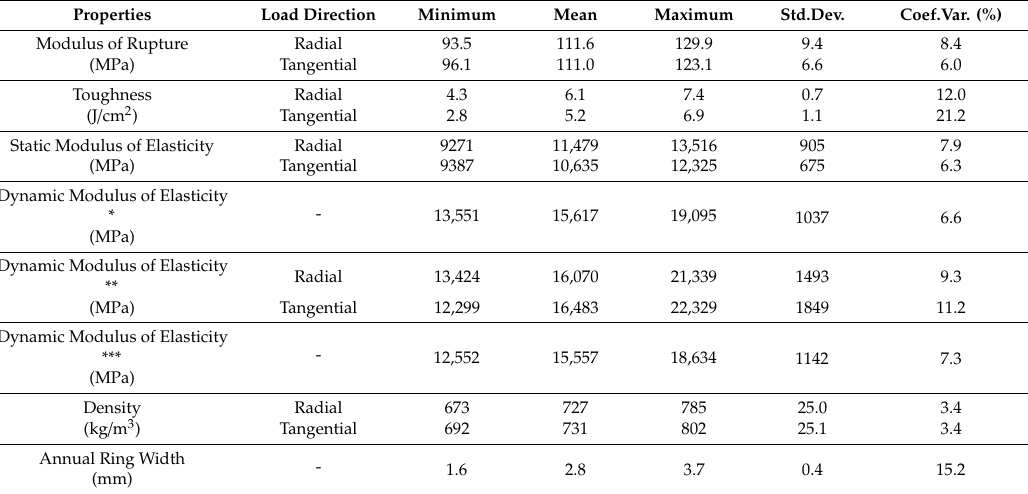
Table 3. Basic Statistical Analyses of the Properties for Beech